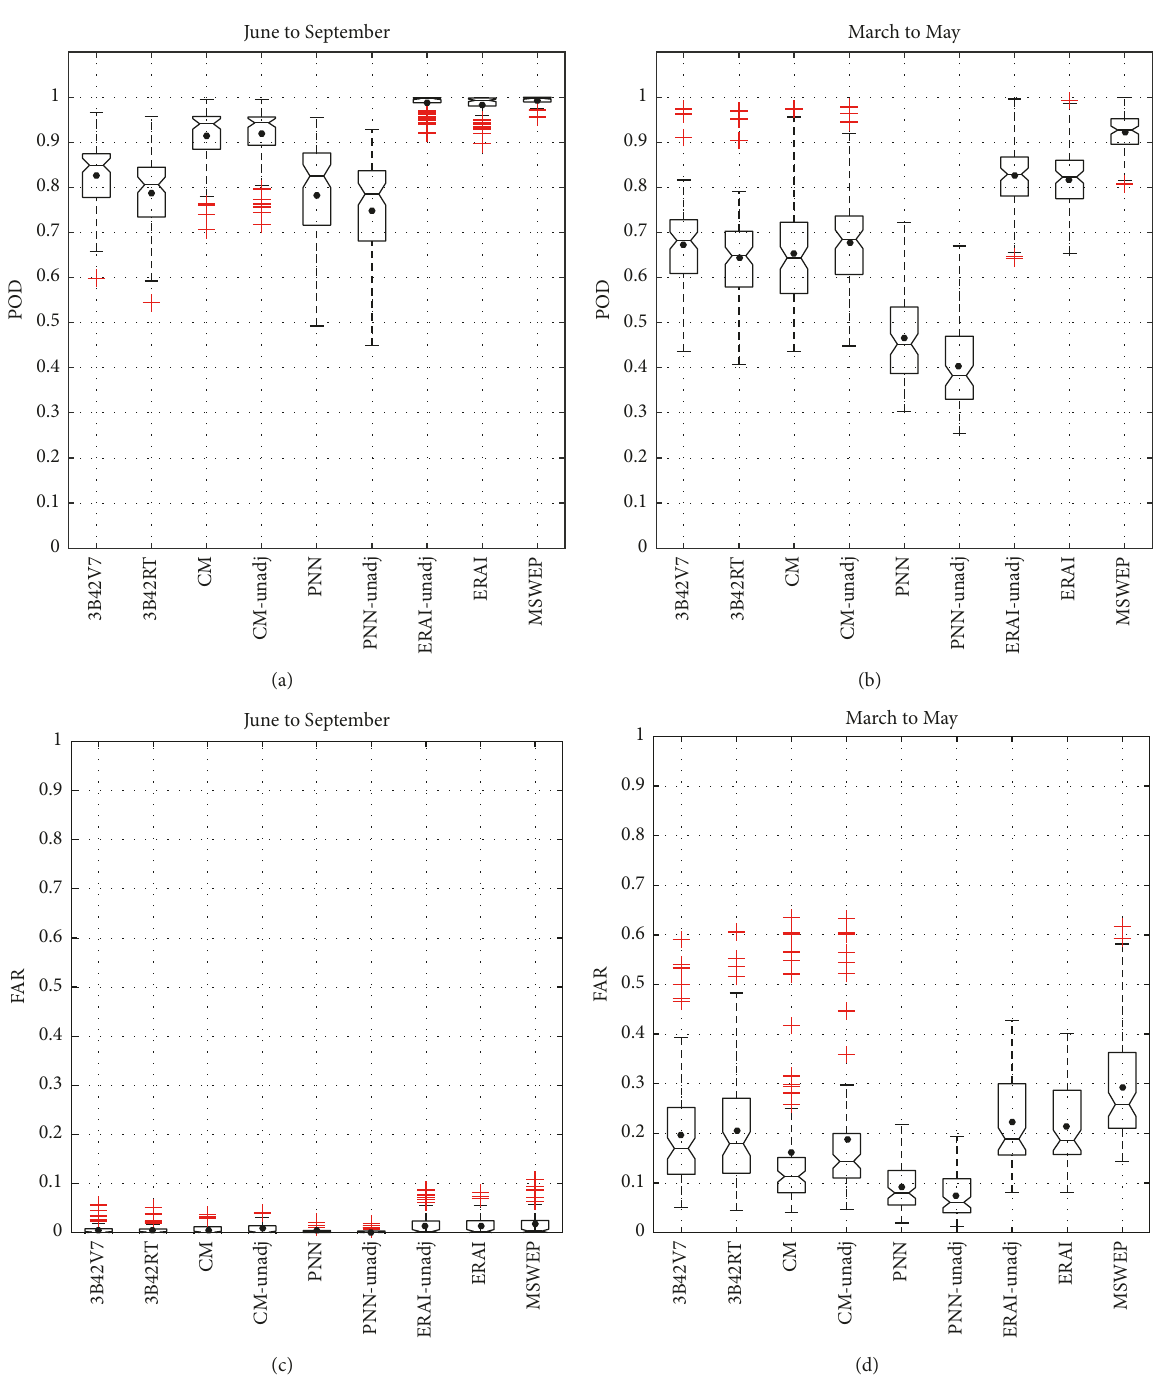
Figure 4: Categorical statistics for (a) POD for June to September, (b) POD for March to May, (c) FAR for June to September, and (d) FAR for March to